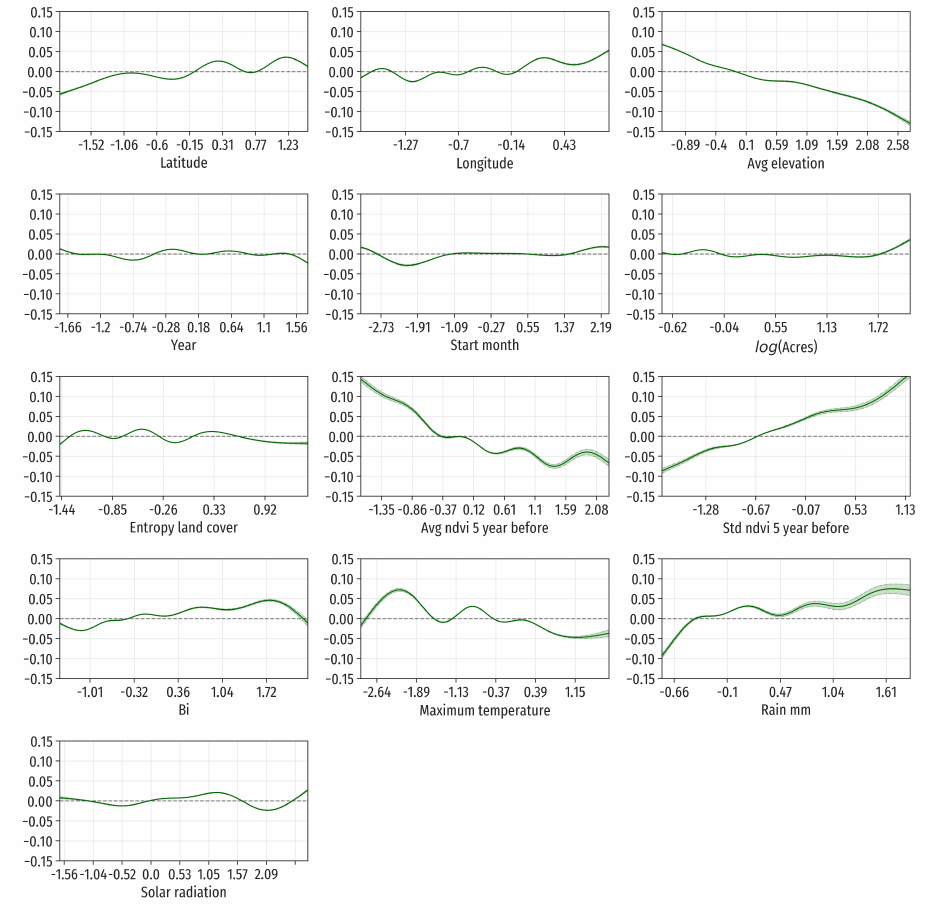
Figure 8. Full function-on-scalar additive model. Estimated smooth terms of the form s j ( x j )